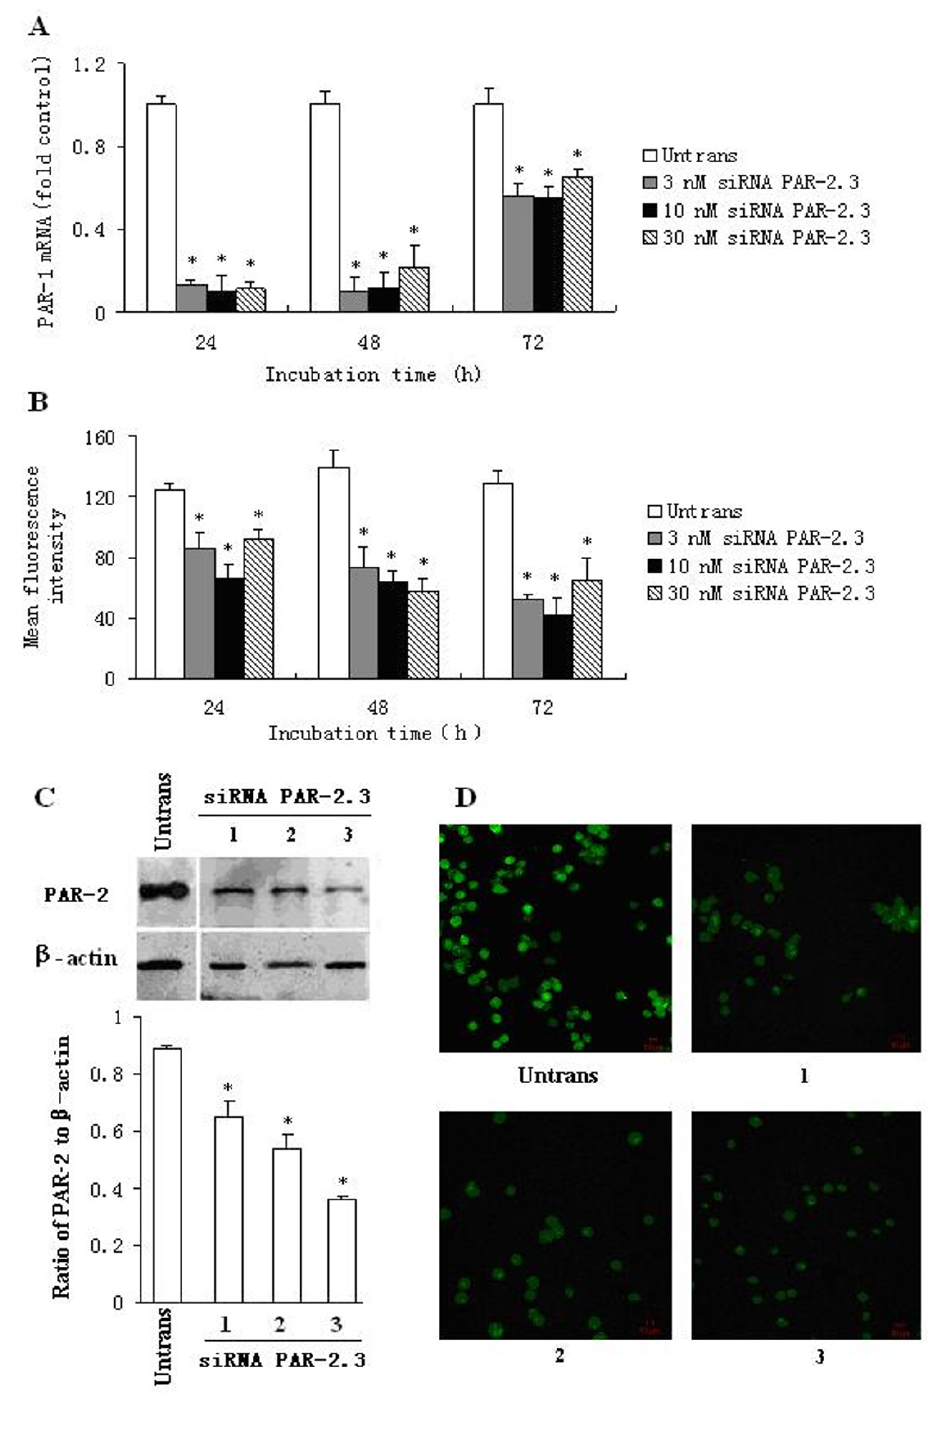
Figure 2 Effect of siRNA PAR-2.3 on PAR-2 expression in P815 cells . P815 cells were transfected with siRNA PAR-2.3 for 24, 48 and 72 h. The PAR-2 expression was determined by real-time quantitative PCR (A), flow cytometry (B), Western blot (C) and immunofluorescent analysis (D). In (C) and (D), 1 = 3 nM, 2 = 10 nM and 3 = 30 nM of siRNA PAR-2.3. Values shown are mean ± SEM for four to five independent experiments. * P < 0.05 compared with the untransfected